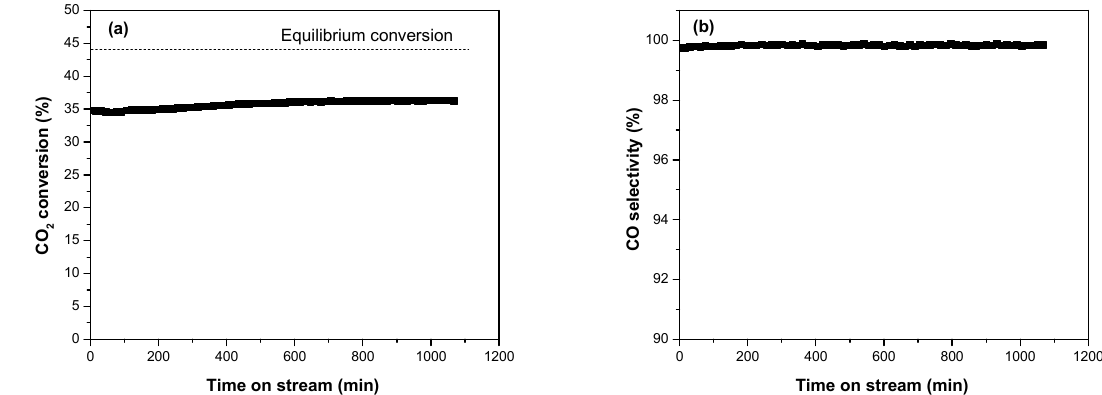
Figure 5. The catalytic performances of 1%Ni/SBA-15 and 1%Ni/SBA-15(P) catalysts in the RWGS reaction: ( a ) CO 2 conversion, ( b ) CO selectivity.